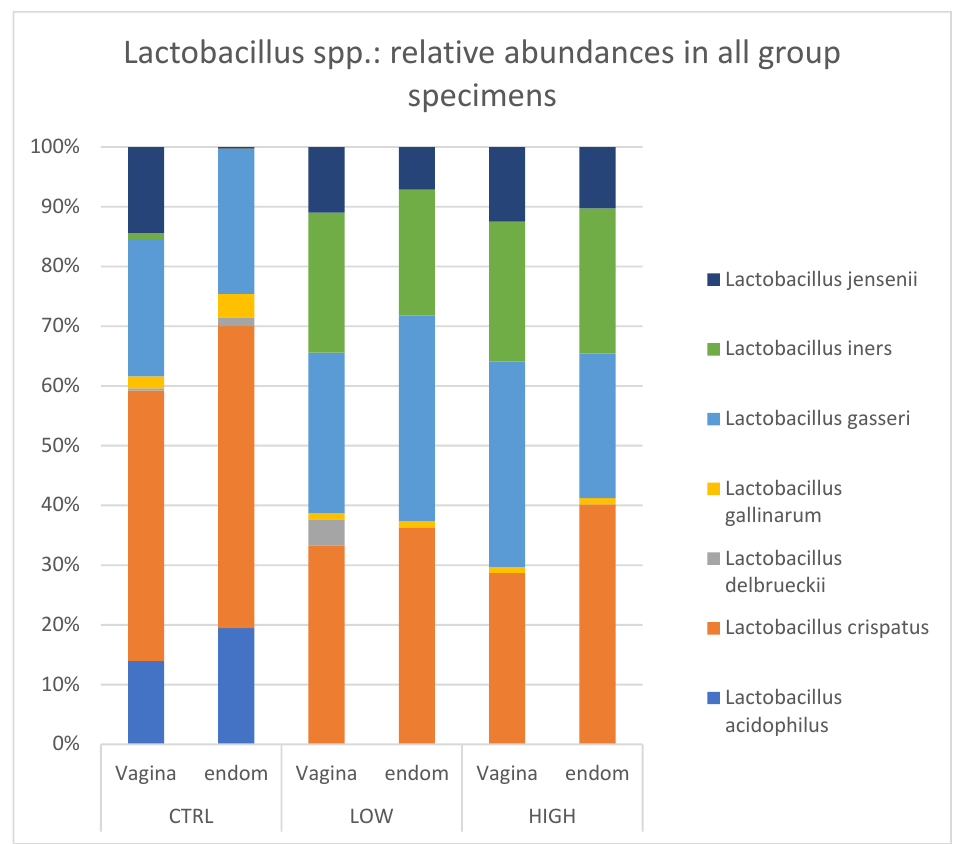
Figure 5. Lactobacillus spp.: relative abundances in all group specimens. Legend: CTR = control; Low= HLA DQ2 DQ8 negative-RPL; High: HLA DQ2 DQ8 positive-RPL.